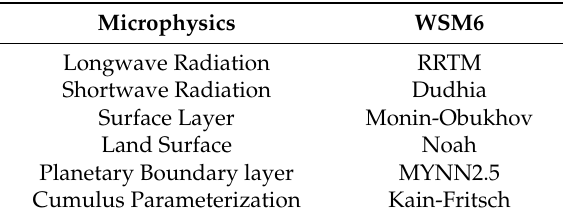
Table 1. Physical parameterization schemes for